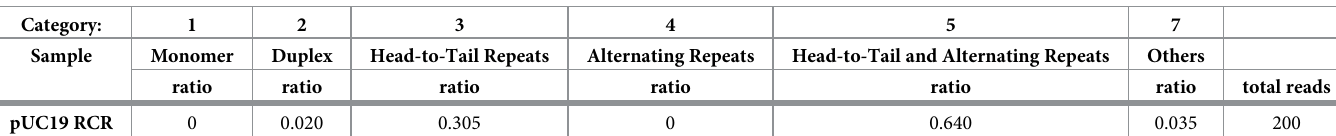
showing a structure with a combination of head-to-tail and alternating concatemers as described for category 5. Phi29 polymerase-mediated generation of ds DNA was previously characterized and suggested to occur upon template switch [30]. Template switch of the RCA product would lead to concatemers containing head-to-tail repeats, which change polarity to continue further with head-to-tail repeats as seen in our reads assigned to category 5. There- fore, those previous results are in line with our observations. Furthermore, we found structures